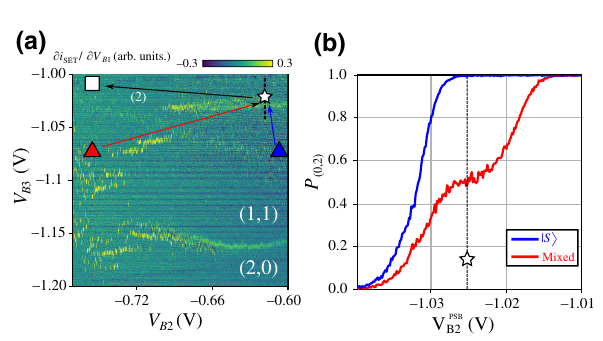
FIG. 6. Calibration of the Pauli-spin-blockade position in the voltage-gate space. (a) Pulse sequence performed to cali- brate the PSB position. The system is initialized in a S or mixed S - T 0 state via a 500 ns voltage pulse at the blue or red trian- gle, respectively. It is then pulsed to the PSB position (white star) during 20 ns to perform a spin-to-charge conversion and the configuration of the DQD is read at the white square position during 5 ms. (b) PSB calibration experiment. The pulse sequence described in (a) is performed for a varied position of the PSB along the detuning axis. We plot the (0,2) charge-state probabil- ity as a function of the PSB position along the dotted line V PSB for the two initializations possible. The readout position is cho- sen at the white star position where the mixed-state probability reaches